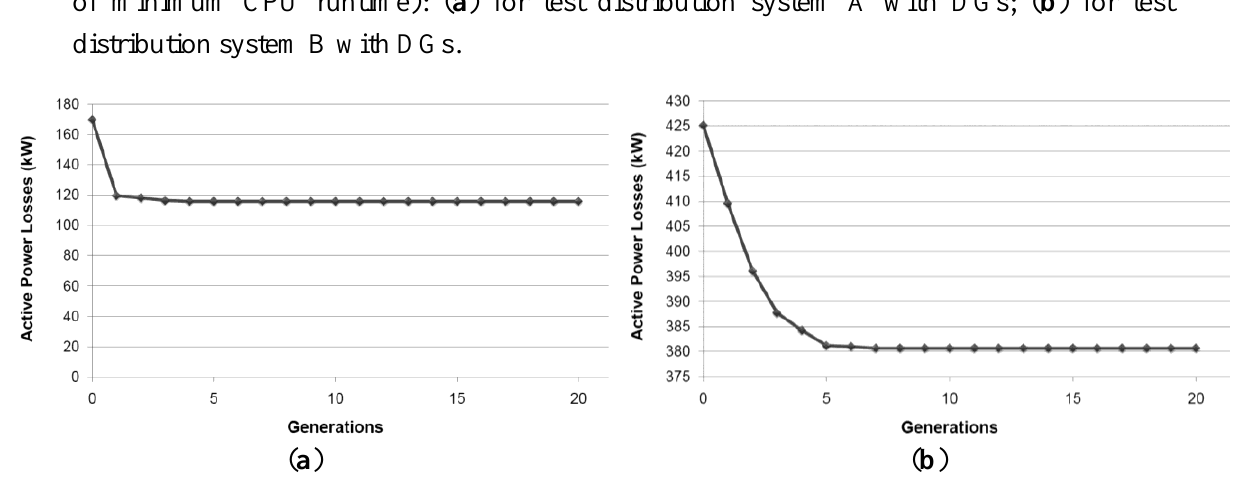
Table 1. Results for different single-objective reconfiguration (test cases with DGs).